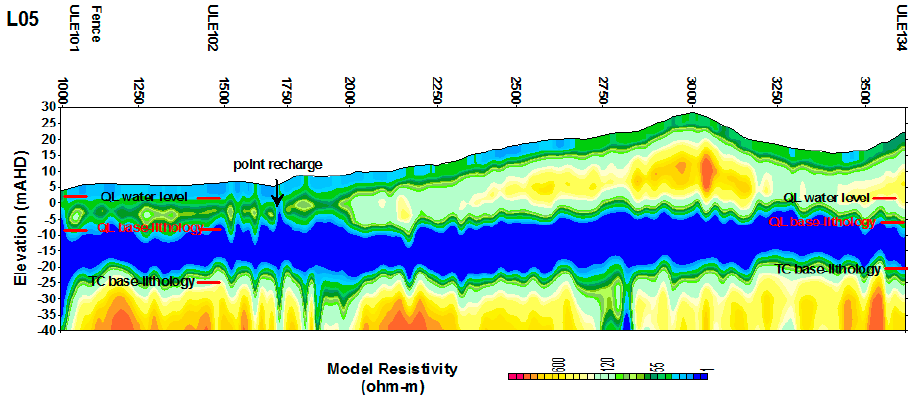
Figure 12. TEM section LO5.